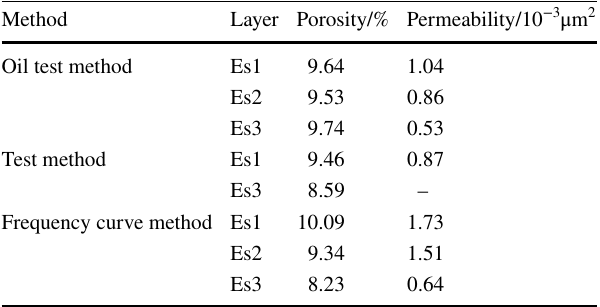
Table 2 Lower limit of reservoir physical properties of the Shahejie Formation in the Dawangzhuang area, Raoyang